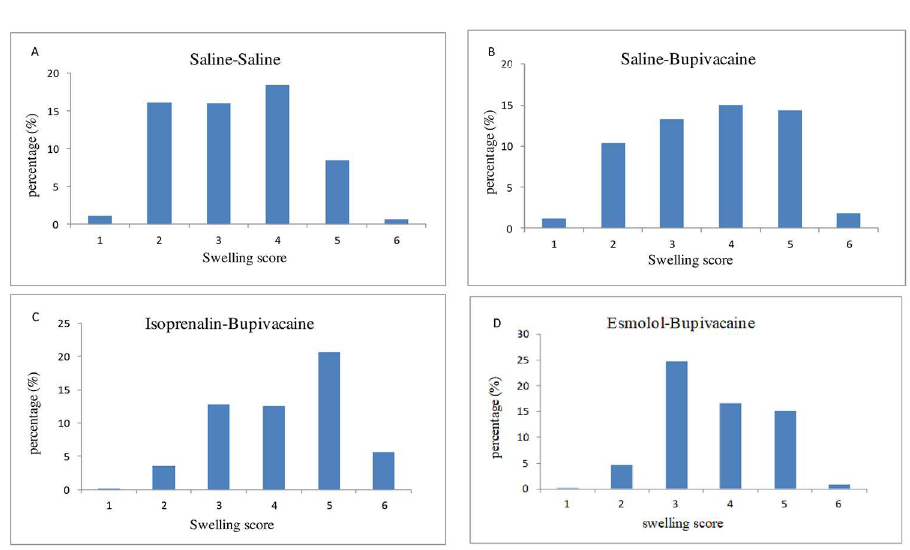
Fig 8. Mitochondrial damage score. Each graph depicts the mitochondrial damage score (0 = no swelling to 5 = maximum swelling) distribution in percent of n evaluated mitochondria in each group. (A) Control mice were pretreated with saline and then received saline i.p. (B), (C) and (D) Mice were pretreated with saline, isoprenalin or esmolol, and then received bupivacaine i.p. The intergroup differences of mitochondrial swelling scores were tested by the Kruskal-Wallis method followed by Nemenyi test for multiple comparisons. The order of the groups according to damage score is as follows: isoprenalin + bupivacaine group (C) > saline + bupivacaine group (B) > esmolol + bupivacaine group (D) > saline + saline group (A) ( P < 0.01, between each two